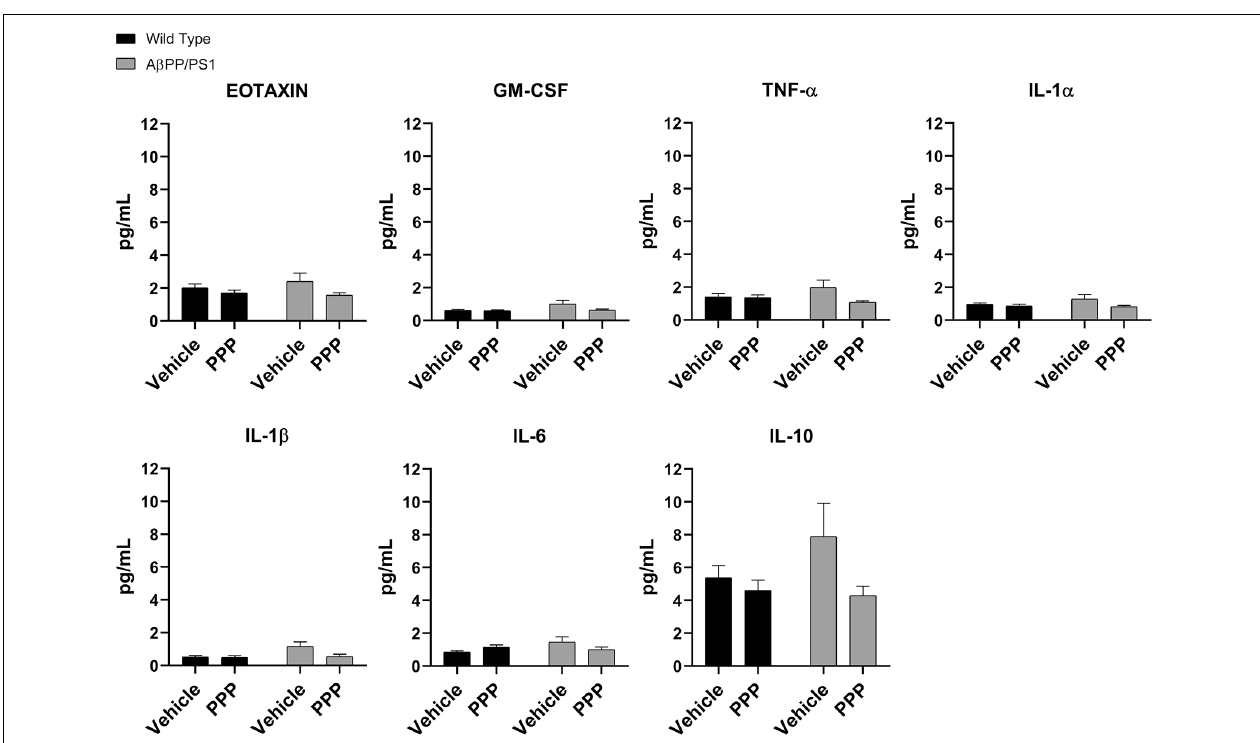
FIGURE 5 | IGF-1R inhibitor treatment did not alter cytokines in the brains of A β PP/PS1 mice. ELISAs were performed to quantify levels of cytokines in temporal cortex lysates from WT and A β PP/PS1 mice that were vehicle or PPP (1 mg/kg, 7 days) treated. Data are mean values normalized to tissue wet weight ± SEM ( n = 6–8 animals). Two-way ANOVA p (interaction) = 0.1805; Eotaxin F (1,24) = 0.9376 and p (interaction) = 0.3426; GM-CSF F (1,23) = 1.908 and p (interaction) = 0.1805; TNF- α F (1,24) = 2.932 and p (interaction) = 0.0997; IL-1 α F (1,24) = 1.900 and p (interaction) = 0.1808; IL-1 β F (1,24) = 3.203 and p (interaction) = 0.0861; IL-6 F (1,24) = 4.326 and p (interaction) = 0.0484; IL-10 F (1,24) = 1.809 and p (interaction) = 0.1911. The errors from comparisons of several pairs of means in the experiment were adjusted using Tukey’s multiple comparison